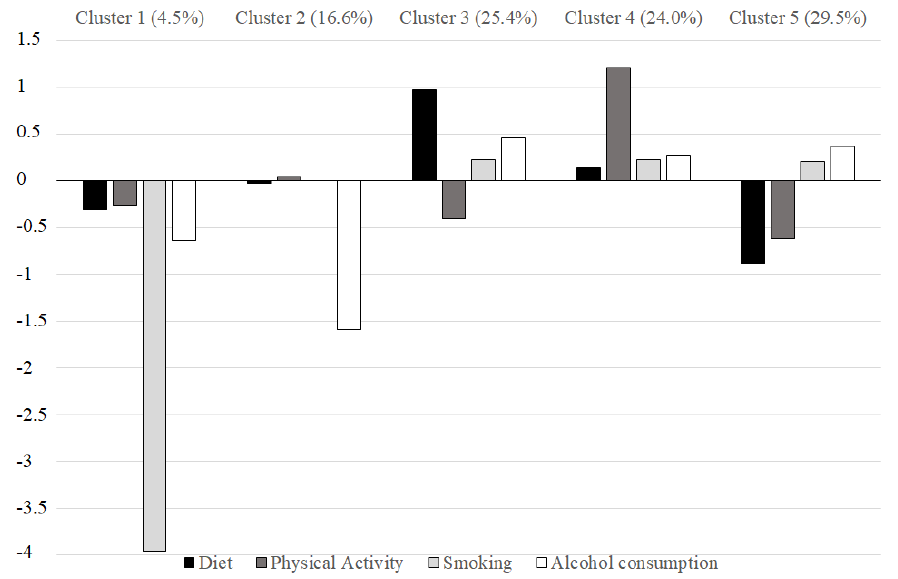
Figure 2. Z-scores of lifestyles for the final five-cluster solution.